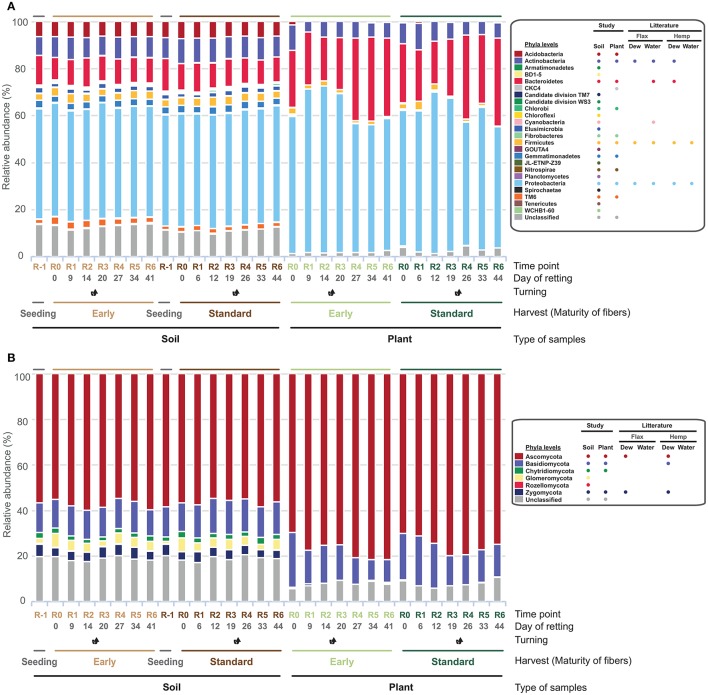
Bacterial (A) and fungal (B) relative abundance of OTUs at the phyla level (soil samples n = 16, and plant samples n = 14). The consensus taxonomy for bacterial OTUs was assigned from the SILVA database and for fungal OTUs from the UNITE database.